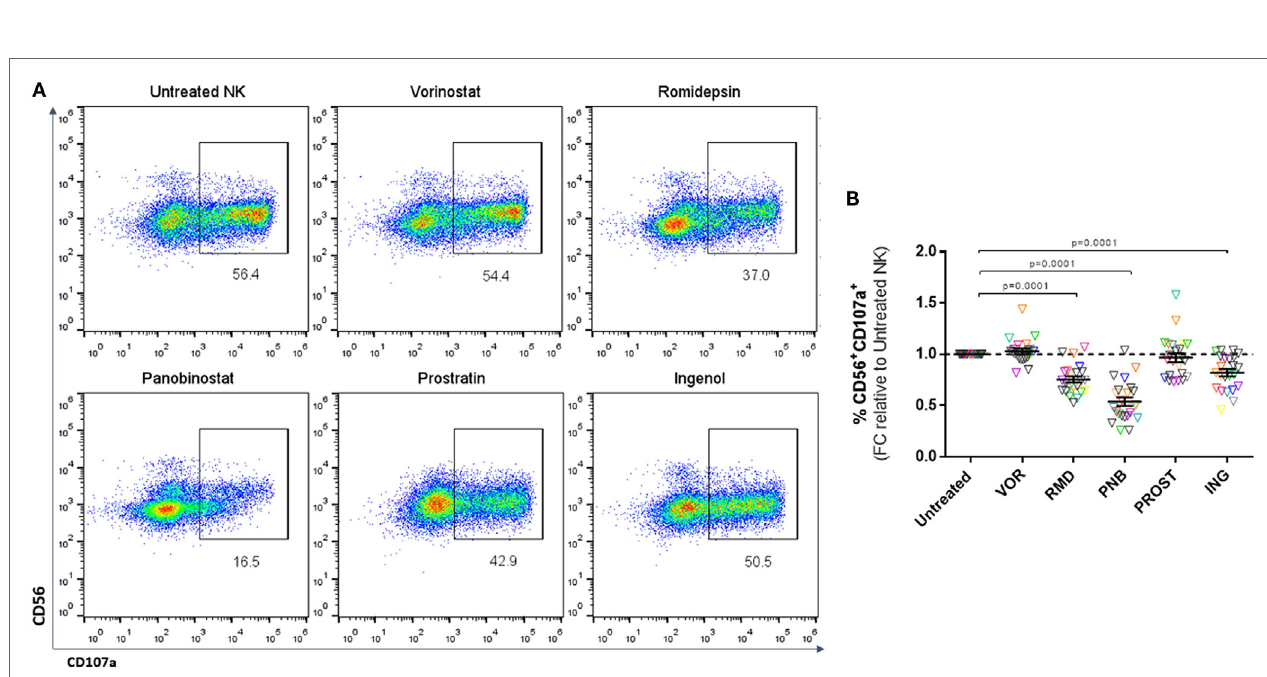
FigUre 2 | Toxicity of lras on nK cells . Proportion of dead NK cells after 24-h exposure to the different LRAs. (a) Representative FACS analysis showing the gating strategy to identify dead cells according to Annexin V and 7-AAD staining. Cell death was considered when cell were double positive for Annexin V and 7-AAD. (B) Proportion of dead NK cells after exposure to the different LRAs, expressed as fold change relative to the untreated condition. Each color represents cells from a different donor. There was a general trend toward a decrease in viability after exposure with all drugs except for ING, but RMD and PNB impact was more pronounced and significantly higher than VOR, PROST, or ING ( p < 0.02). N = 7.